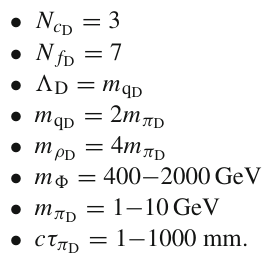
Fig. 5 Bounds from direct detection and collider searches for m p shaded region the dark matter is larger than the mediator mass. Figure taken from [87] right to κ = diag ( 0 . 1 , 1 , 1 ) . This shows clearly how